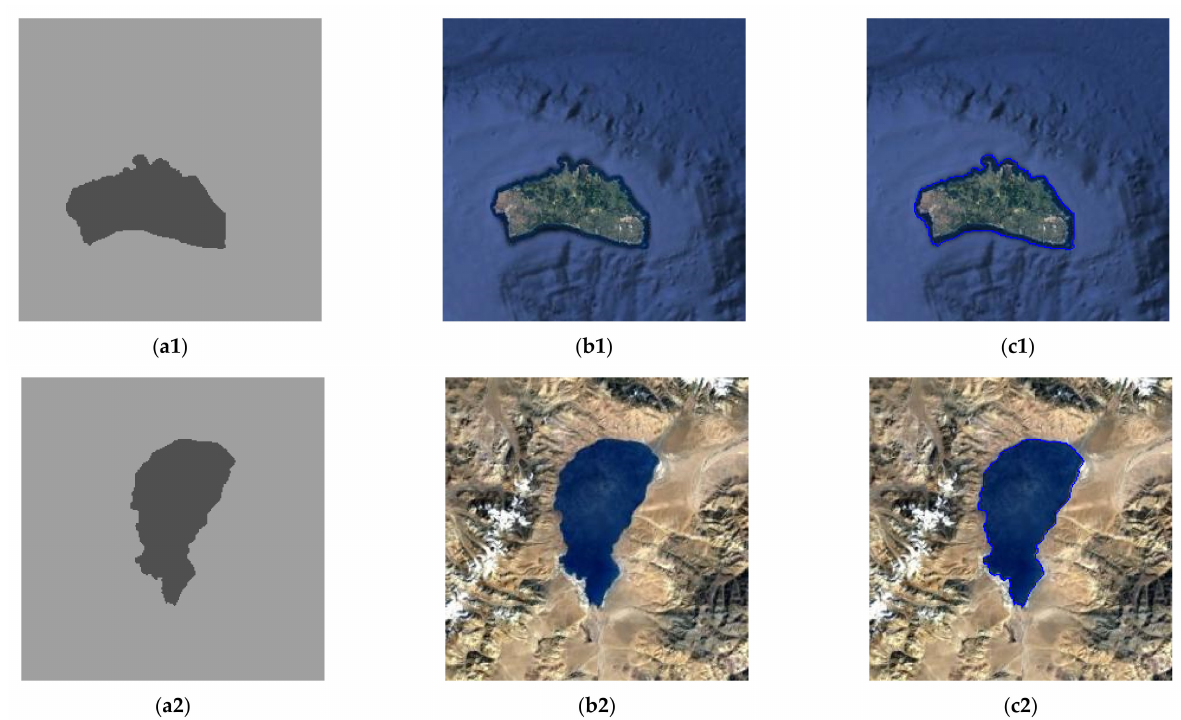
Figure 10. Island and lake experimental images: ( a1 ) Island standard image; ( b1 ) Island image; ( c1 ) Island standard contour; ( a2 ) Lake standard image; ( b2 ) Lake Image; ( c2 ) Lake standard contour.